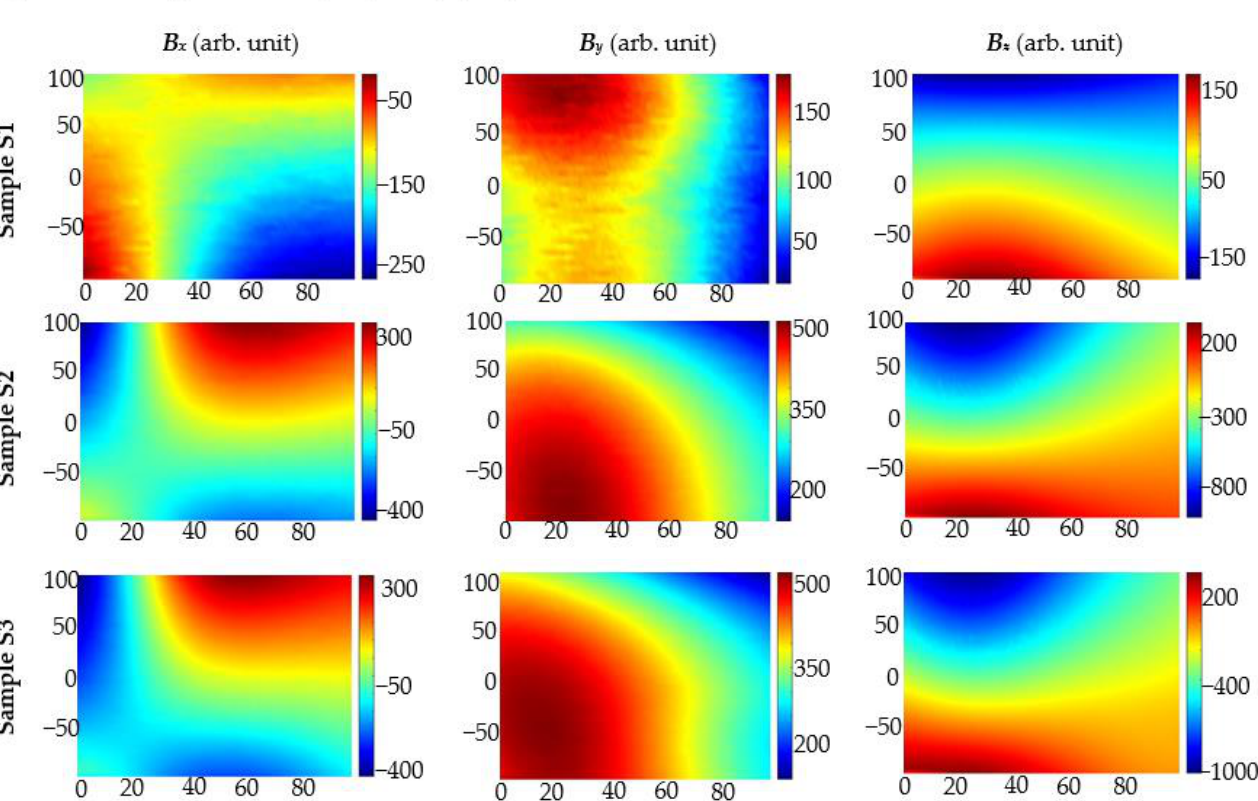
Figure 23. Results of 2D measurements using AMR sensor received for different samples (S1, S2, S3); the magnetization OPM; the thickness of the concrete cover h = 40 mm; x (mm), y (mm) — sensor positions.